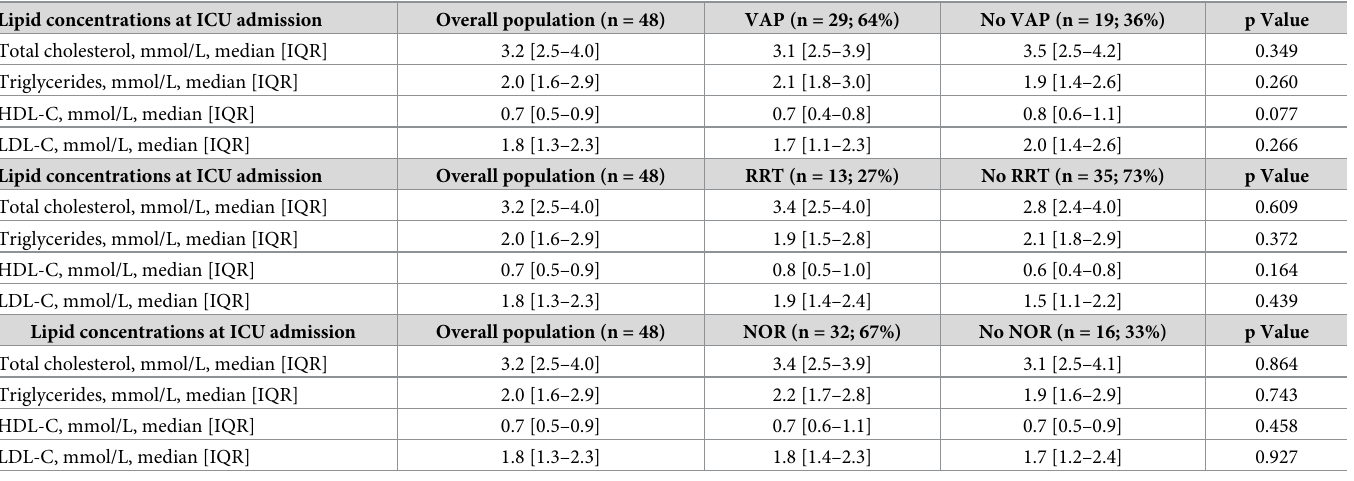
Table 2. Relationship between lipid concentrations at ICU admission and outcome